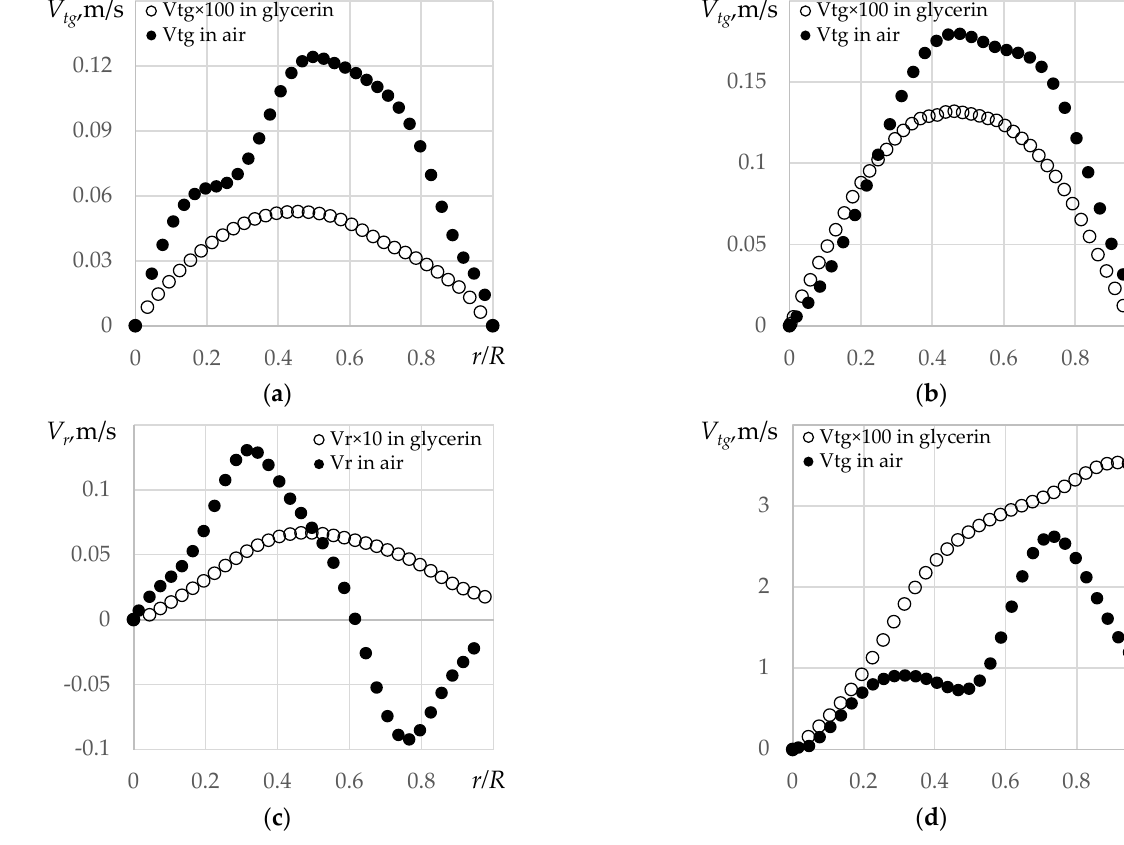
Figure 6. The tangential velocity profiles at Ω = 90 rpm: ( a ) h = 0.5; ( b ) h = 0.8; and ( c,d ) the radial and tangential velocities at Ω = 720 rpm and h = 0.5, respectively.